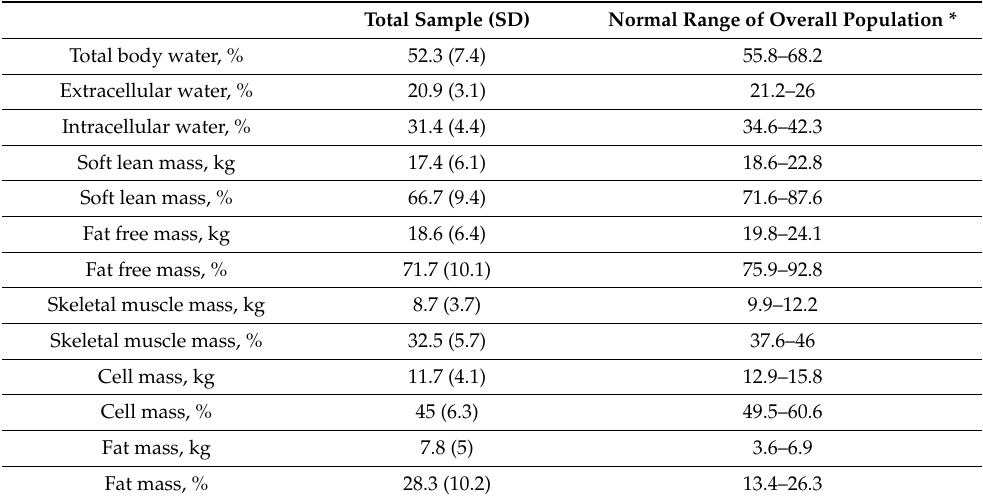
Table 2. Body composition calculated by bioelectrical impedance analysis (BIA) ( n = 20).